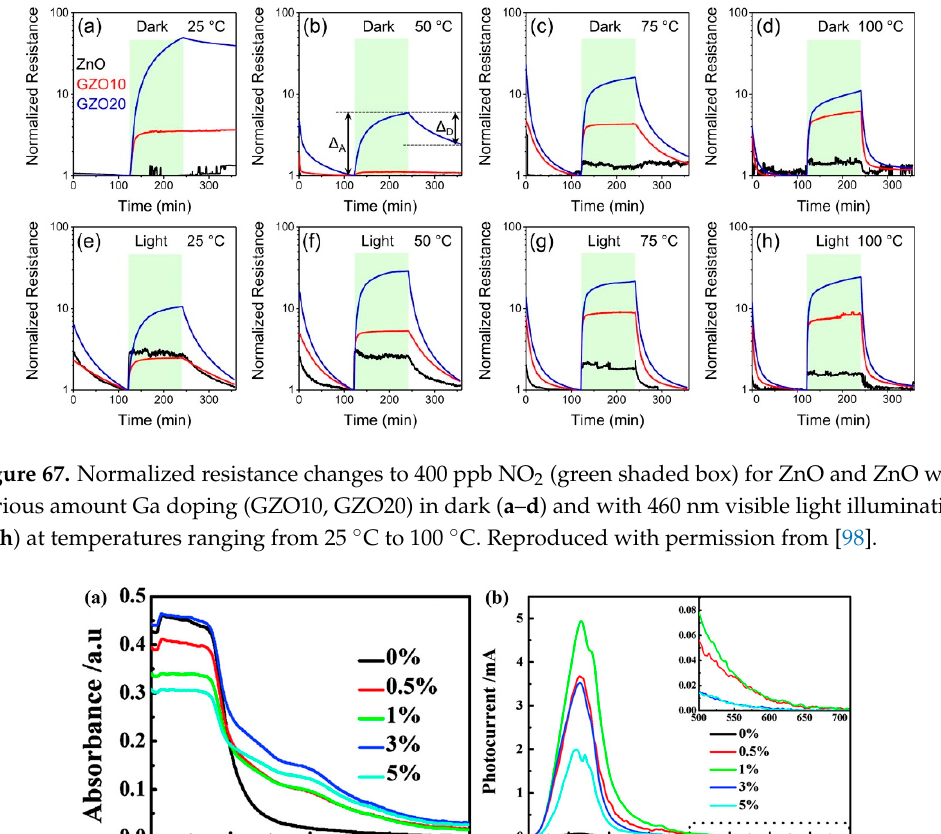
Figure 67. Normalized resistance changes to 400 ppb NO 2 (green shaded box) for ZnO and ZnO with various amount Ga doping (GZO10, GZO20) in dark ( a – d ) and with 460 nm visible light illumination ( e – h ) at temperatures ranging from 25 °C to 100 °C. Reproduced with permission from [98].